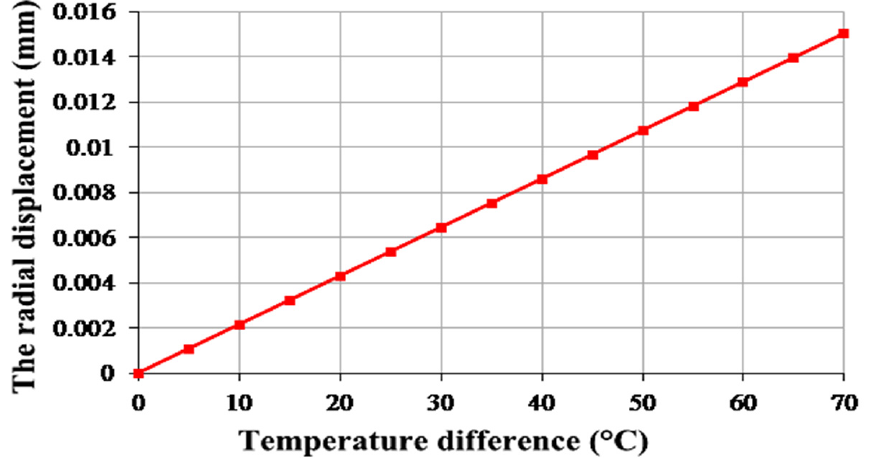
Figure 4. Radial displacement of casing under different temperature difference.